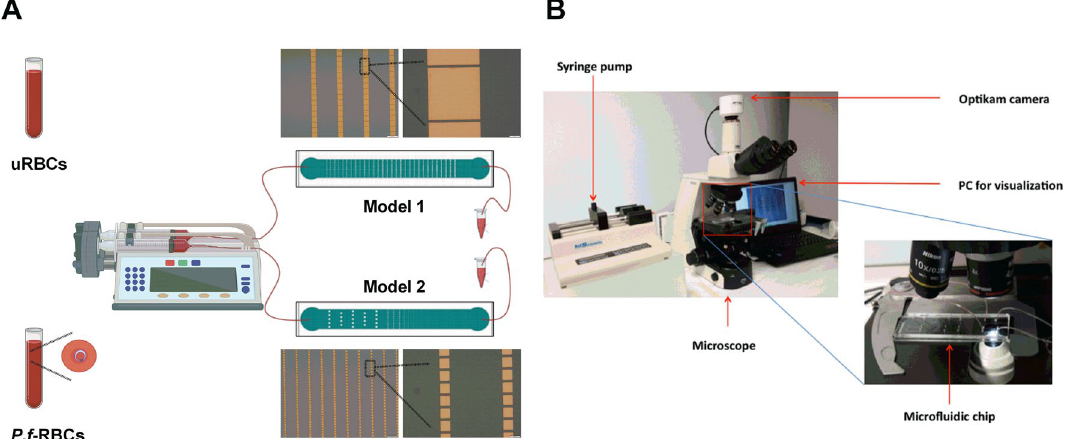
Figure 3. Pitting experimental setting. ( A ) Representation of uRBCs and P.f.- RBCs samples injection into the microfluidic devices and post-chip sample collection. ( B ) Images showing the equipment used for sample application into the devices connected to an optical microscope and the computer for visualization and recording. The drawings were created with